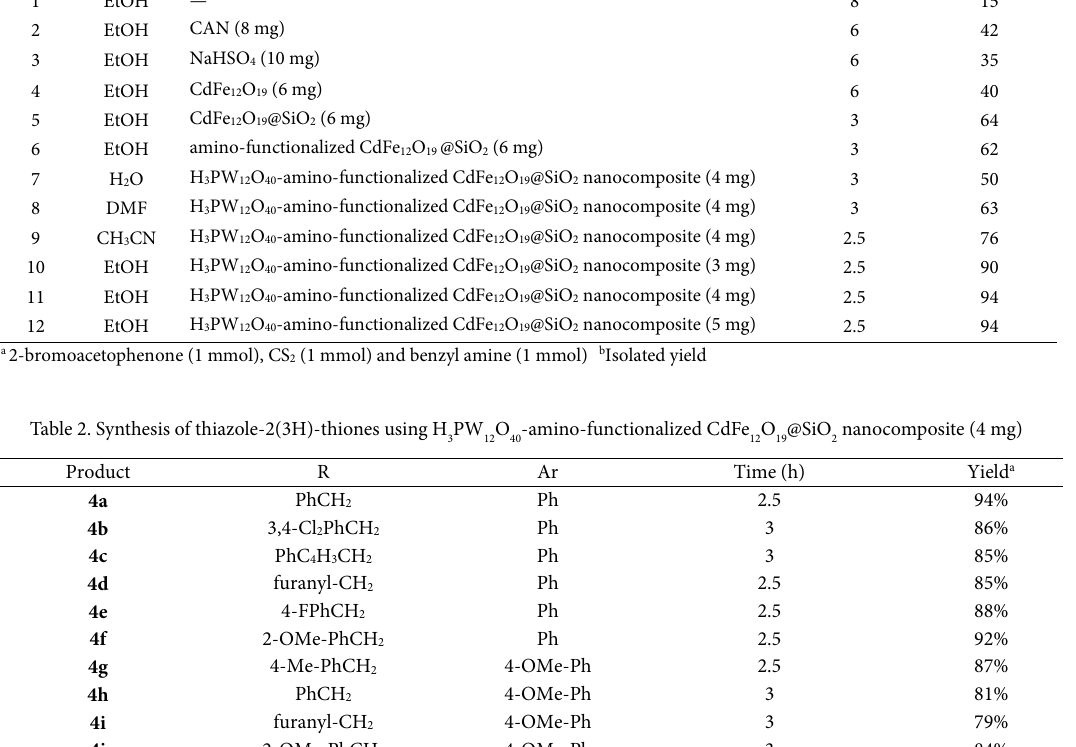
Table 1 . Optimization of reaction conditions a Table 1. Optimization of reaction conditions a